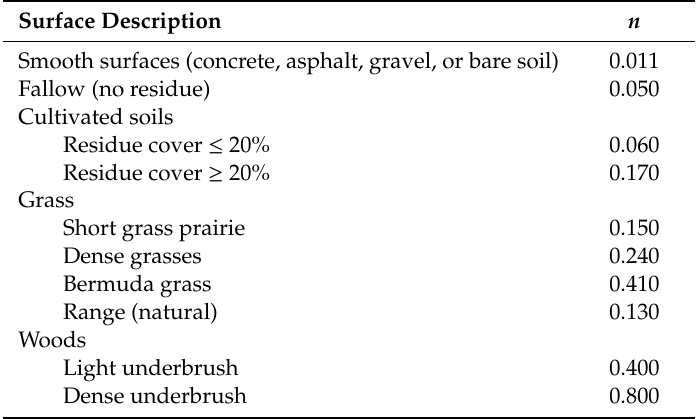
Table 3. Manning’s roughness coe ffi cients ( n ) for overland flow